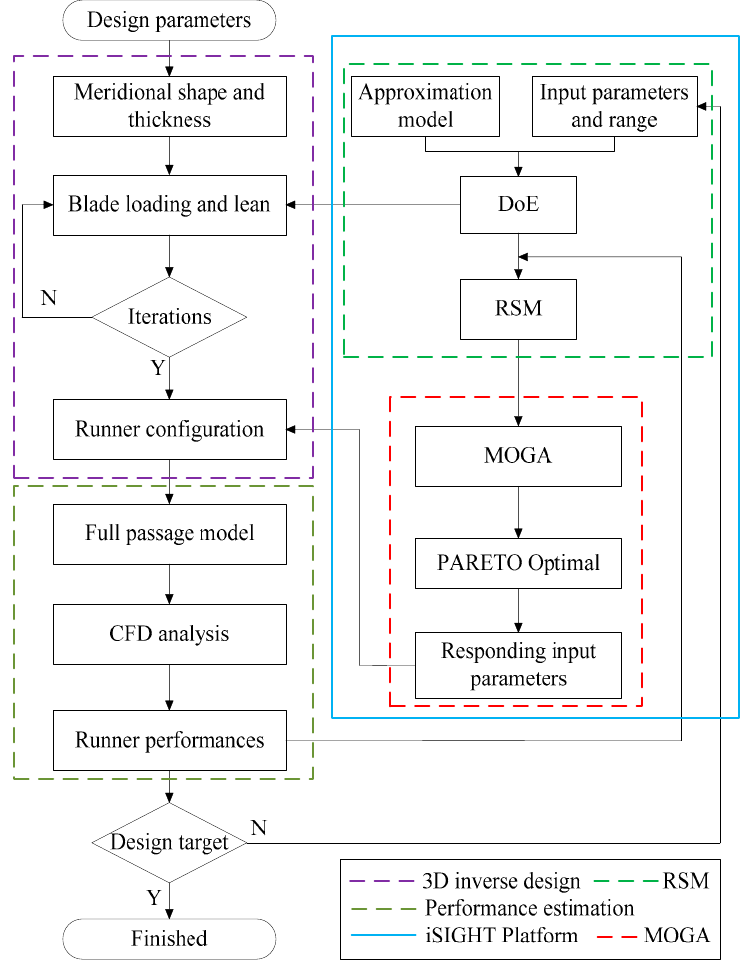
Figure 1. Procedures for multiobjective optimization.